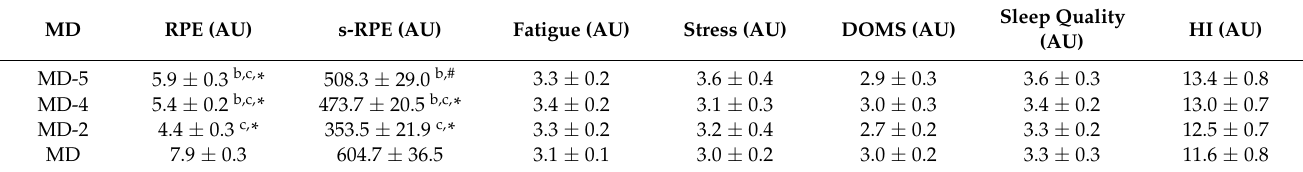
Table 3. Internal Intensity and Wellness Profile during training and matches for squad average (mean ±